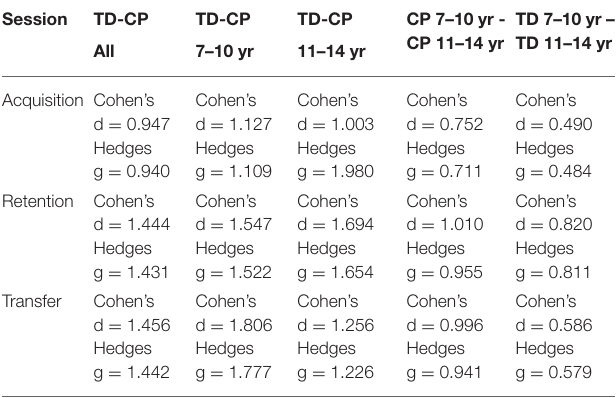
TABLE 3 | Effect sizes for between-group differences at each